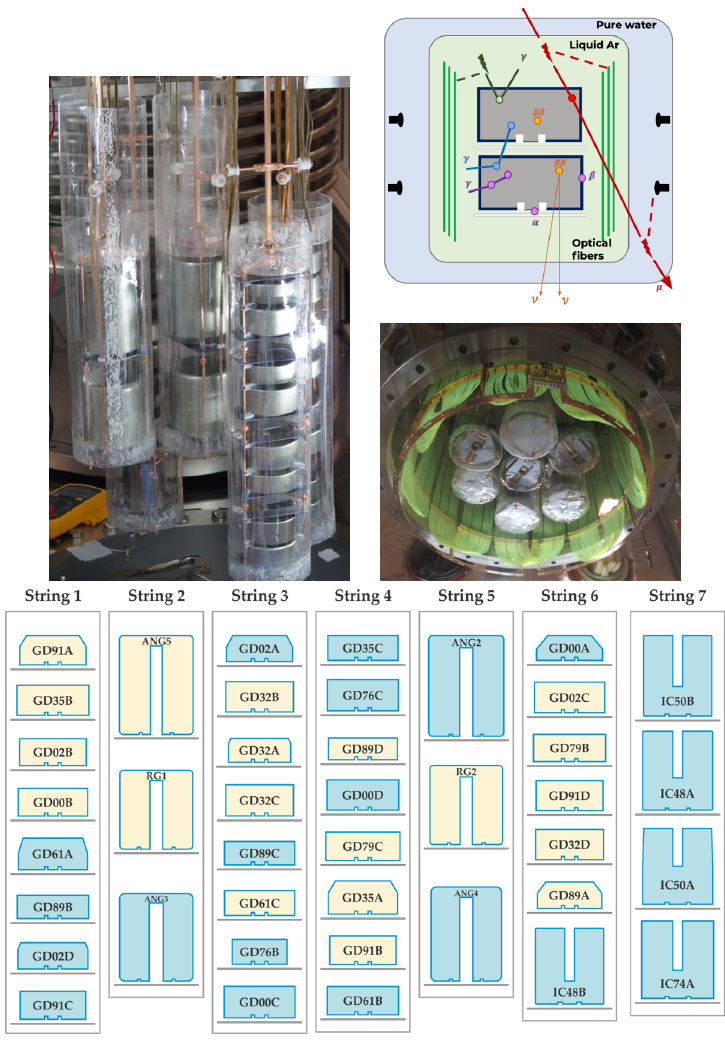
Figure 15. ( Top left ) The Phase II Ge detector array and ( bottom left ) its scheme [30]. ( Top right ) The G ERDA Phase II concept to tag the single-site while minimizing the background events and ( bottom right ) the fiber shroud surrounding the detector strings once lifted up in the